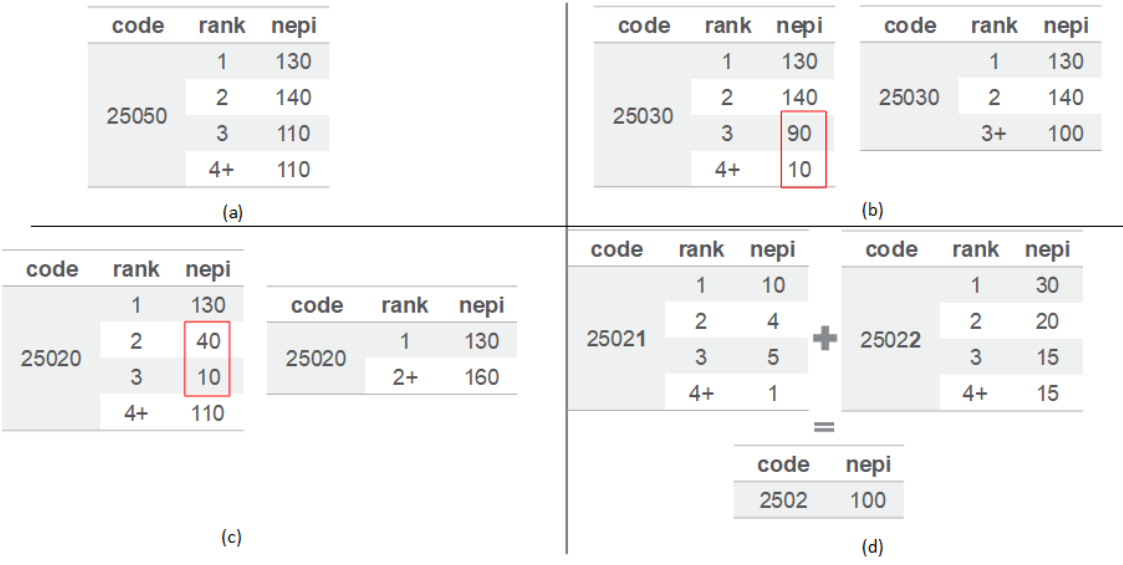
Figure 1. Examples showing rank and ontological adjustments. Observations less than 100 are considered rare. ( a ) no ontological adjustment for the ICD code 25050. ( b ) ontological adjustment for the ICD code 25030. ( c ) ontological adjustment for the ICD 25020 and ( d ) ontological adjustment for both ICD codes 25021 and 25022.